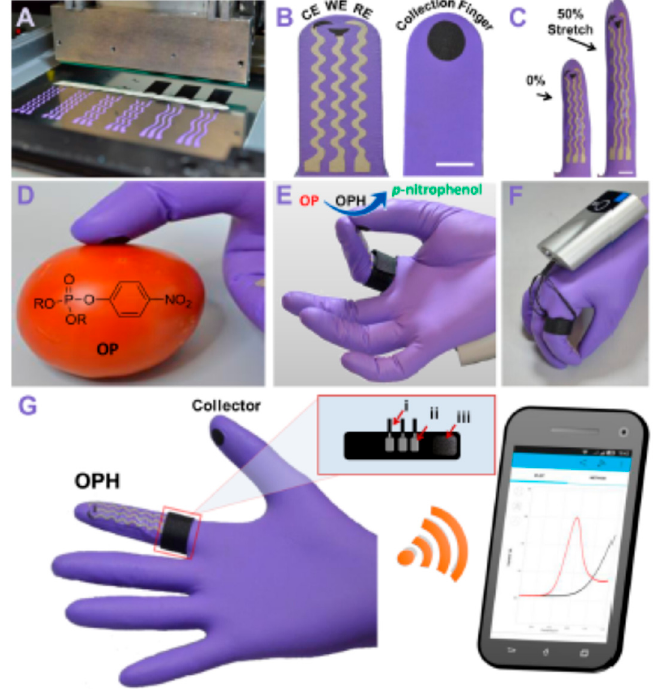
Figure 10. Scheme of the fabrication and functioning of a flexible glove biosensor to detect nerve agents OPs. ( A ) serpentine stencil design printing; ( B ) biosensing scan index finger (left) with CE, WE, and Ag/AgCl RE electrodes, and collecting thumb finger with printed carbon pad; ( C ) biosensing index finger under 0% and 50% linear stretch; ( D ) sampling chemical threat residues; ( E )